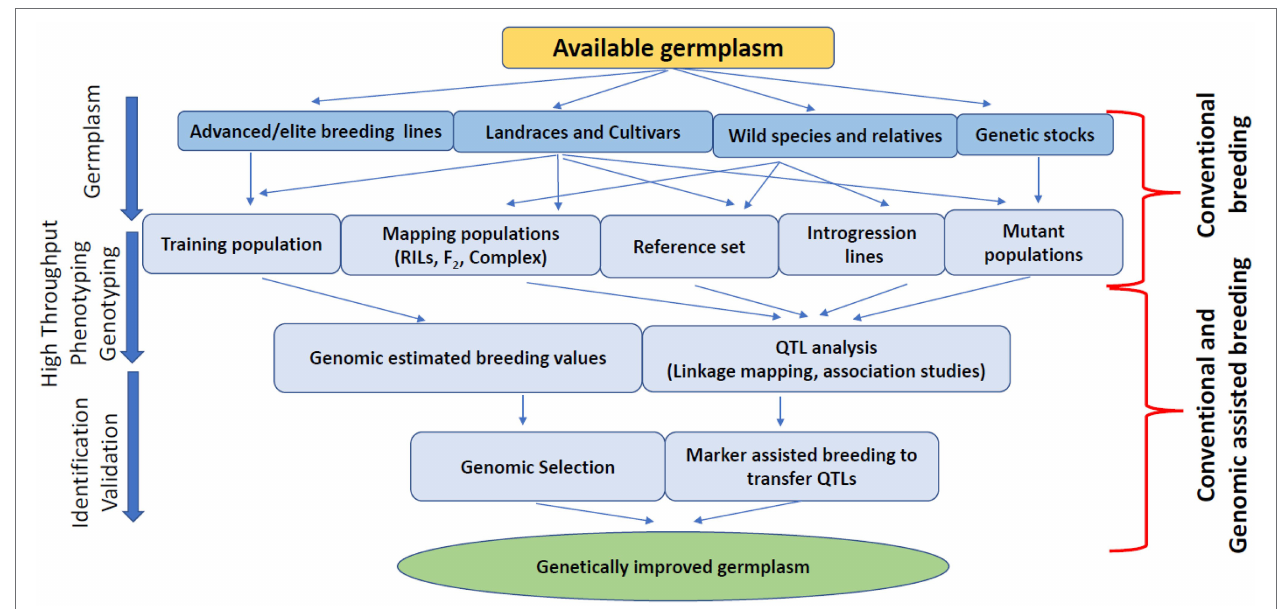
FIGURE 2 | Schematic representation of germplasm improvement for quality